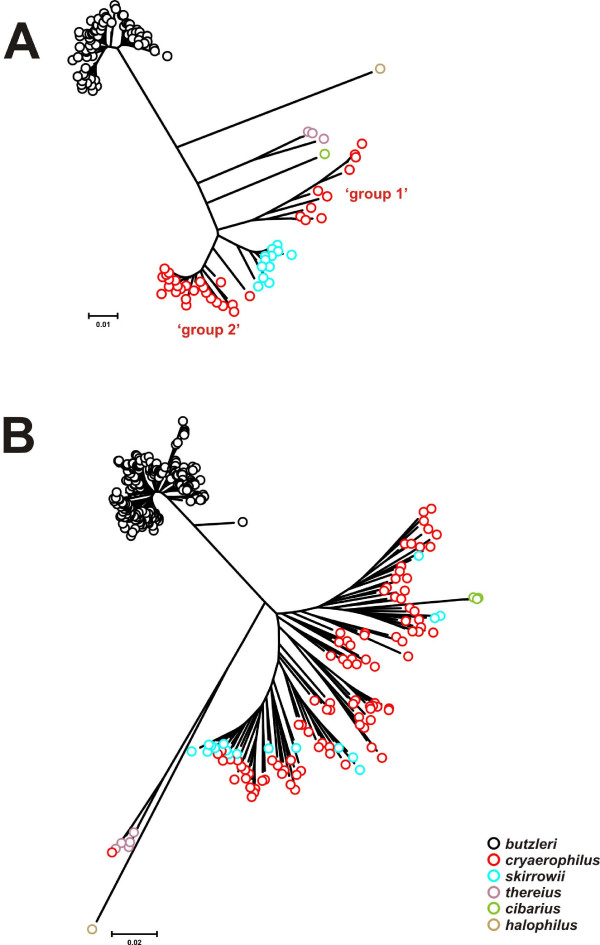
Dendrograms of Arcobacter atpA and glyA alleles. A: atpA; B: glyA. The dendrograms were constructed using the neighbor-joining algorithm and the Kimura two-parameter distance estimation method. The scale bars represent substitutions per site. The A. halophilus strain LA31B atpA and glyA sequences were extracted from the draft A. halophilus genome. Note the presence of a putative laterally-transferred allele within the A. thereius glyA cluster.